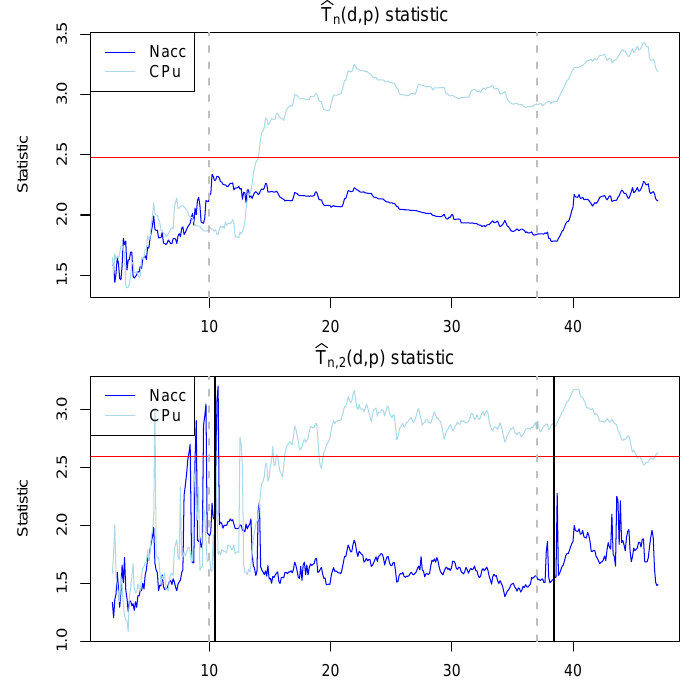
Figure 11. Statistics of the first alcohol drinking event, which lasted about 27 s. Ten seconds before and 10 s after were also included. The red horizontal line indicates the critical value with 0.95. Vertical gray dashed lines mark the beginning and the end of the drinking time. The black solid vertical lines mark the locations of the change-points detected using the restricted p -variation method. Blue and light blue colors represent different brain